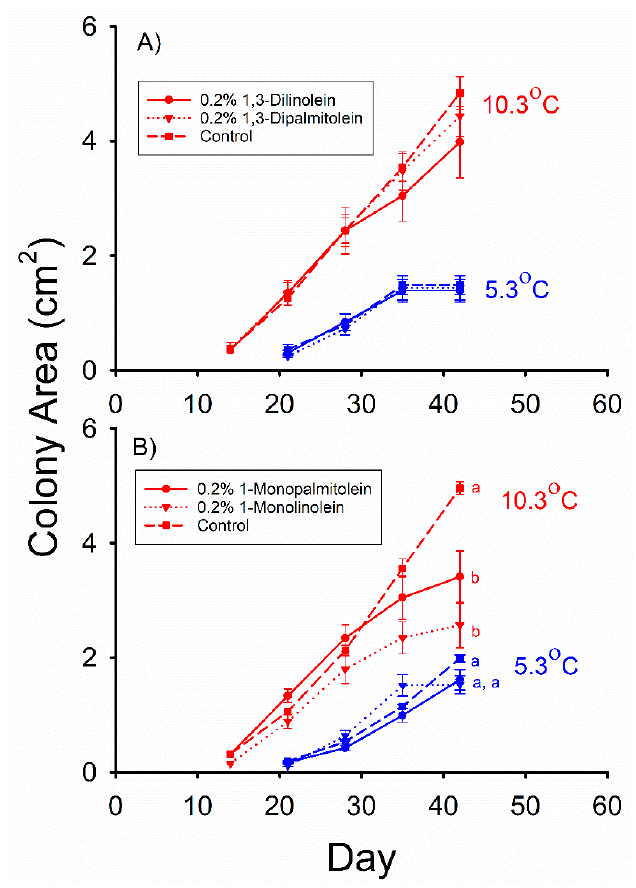
Figure 1. Mean (± SE) surface areas of Pseudogymnoascus destructans colonies at various stages of growth in: ( A ) Experiment 1, and ( B ) Experiment 2 at T a = 5.3 (blue symbols) and 10.3 °C (red symbols). Means within the same T a treatment and experiment sharing a common lower-case letter are not significantly different at the p < 0.05 level .